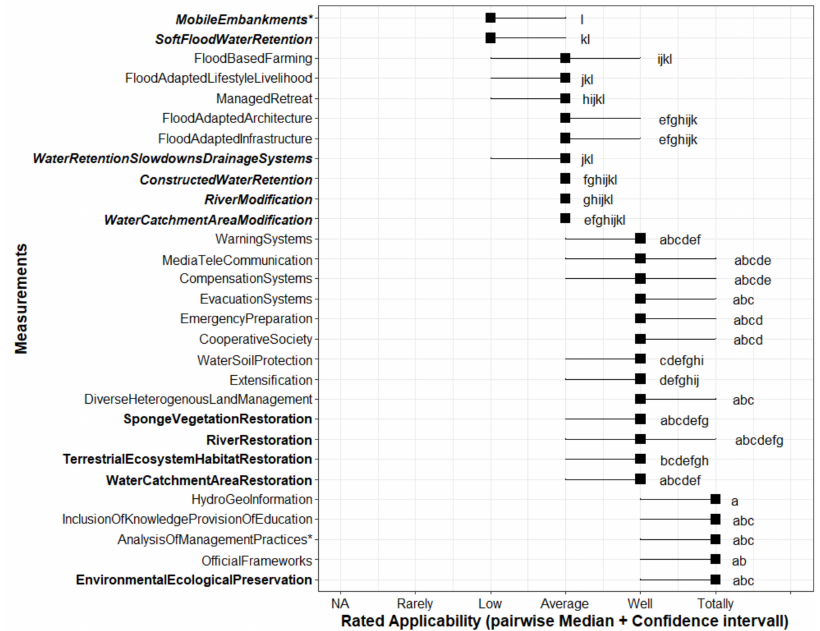
Figure 7. Statistical differentiation by the Friedman Conover test of measures regarding their applica- bility in European rural mountain areas (Friedman χ fm and Kendall Wt test-statistics: p < 2.2 × 10 − 16 , df = 28, χ fm = 231.37, Wt = 0.285). Ratings of measures sharing a letter (e.g., “a” in OfficialFrame- works and RiverRestoration) could not be statistically differentiated. * Only represented in SDS-2. Instrumental (plain), structural ( bolditalic ), and natural solutions ( bold